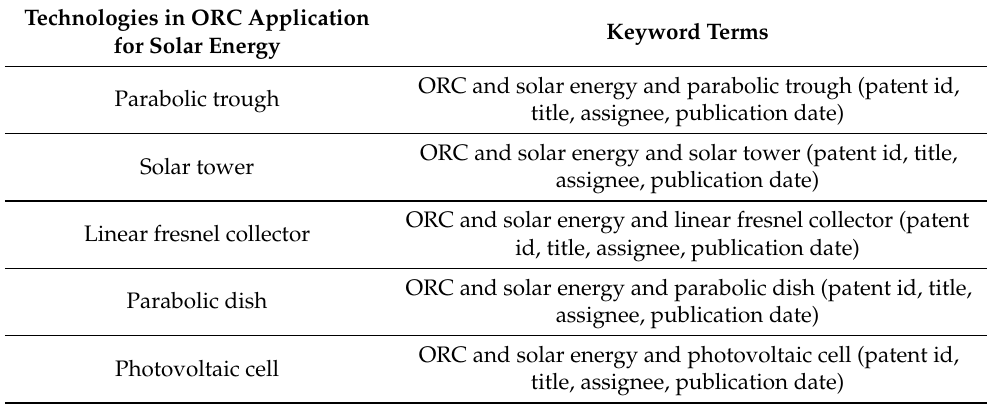
Table 1. Strategy adopted to perform the search using google patents.